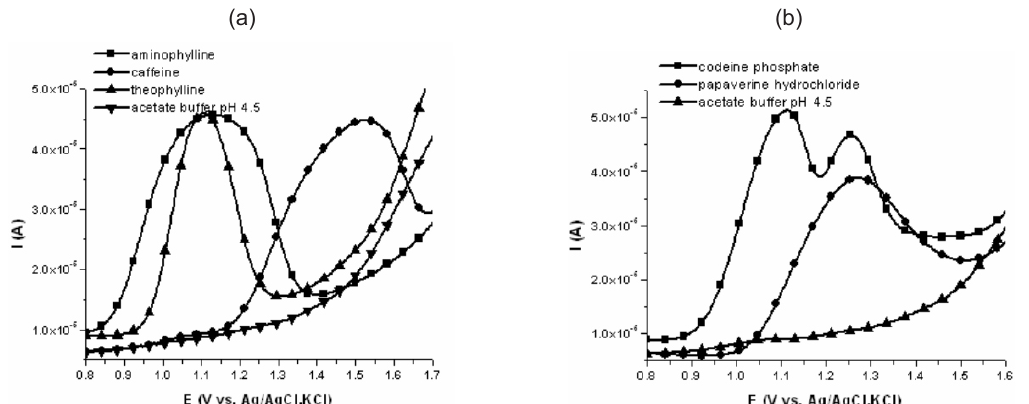
Figure 5. Differential pulse voltammetric curves of 10 -3 mol L -1 : (a) purine alkaloids (aminophylline, theophylline and caffeine); (b) codeine phosphate and papaverine hydrochloride solutions in 0.2 mol L -1 acetate buffer pH 4.5 on electrochemically activated glassy carbon electrode (reference electrode Ag/AgCl; auxiliary electrode Pt wire; scan rate 0.04 V s -1 ; amplitude 100 mV; modulation time 5 ms; 20 o